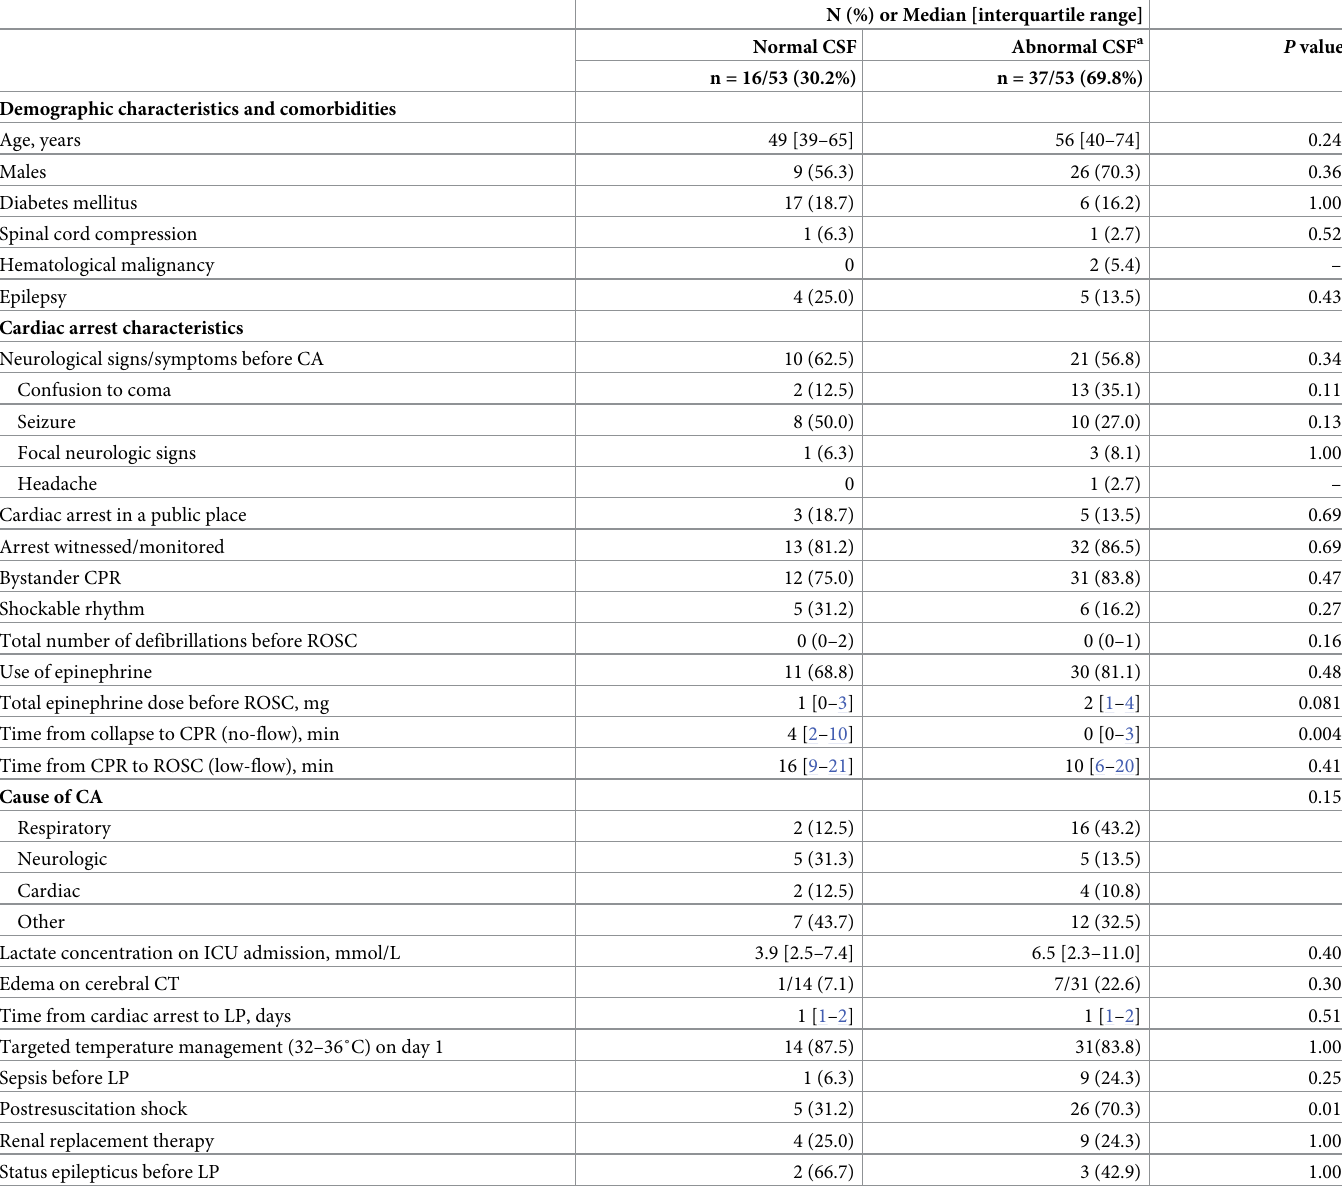
Table 3. Demographic and cardiac arrest characteristics in patients whose cerebrospinal fluid analysis did not contribute to identify the cause of cardiac arrest (n = 53).